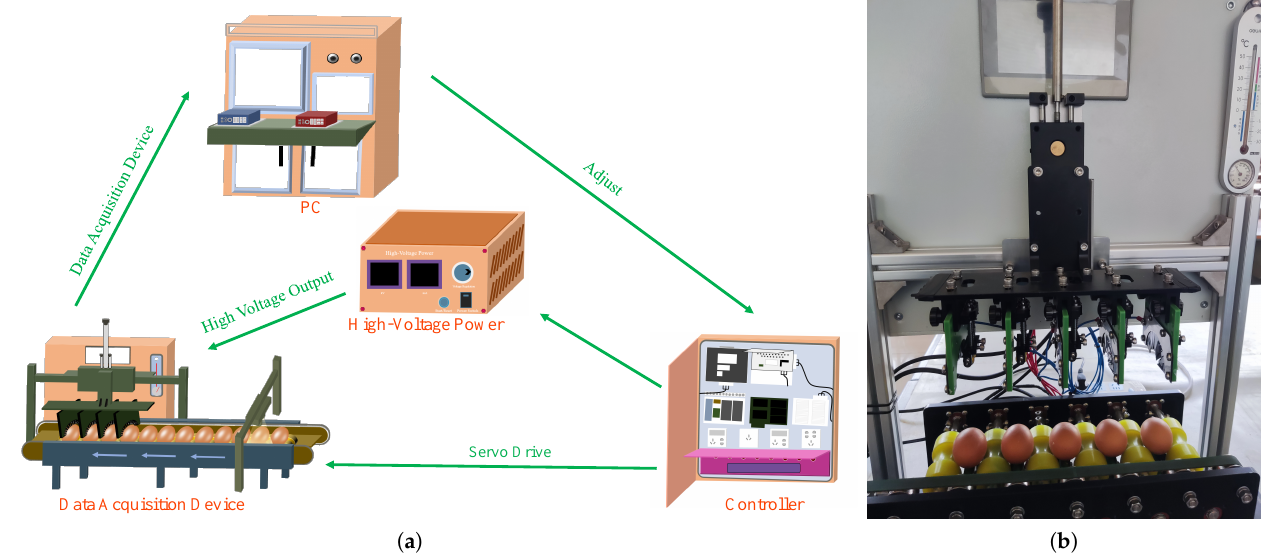
Figure 2. Discharge principle and experimental setup. ( a ) Schematic diagram of poultry egg crack detection system based on real-time electrical characteristics. ( b ) The nondestructive detecting device based on electrical characteristics of eggs used in this